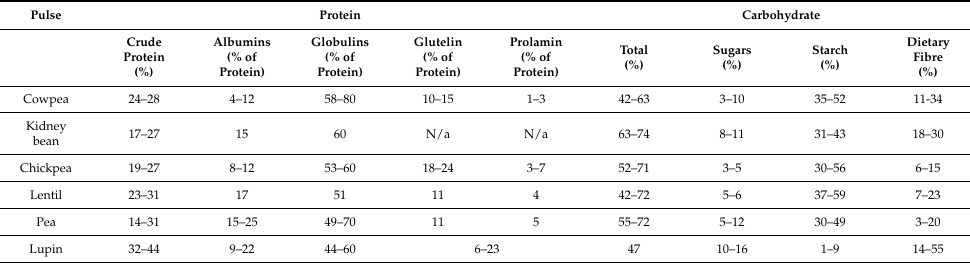
Table 3. Protein and carbohydrate content and proportion of protein and carbohydrate classes in